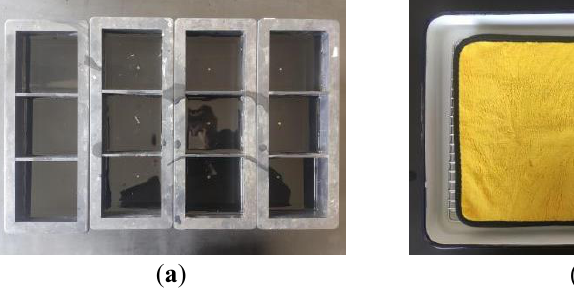
Figure 3. Schematic diagram of three freeze–thaw methods test. ( a ) Immersion freeze–thaw; ( b )